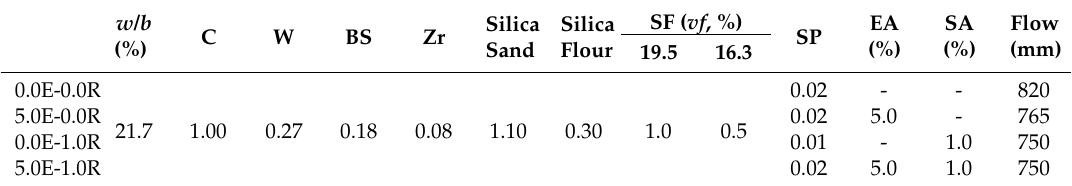
Table 1. Proportion of materials in the HPC mixture by cement weight ratio.